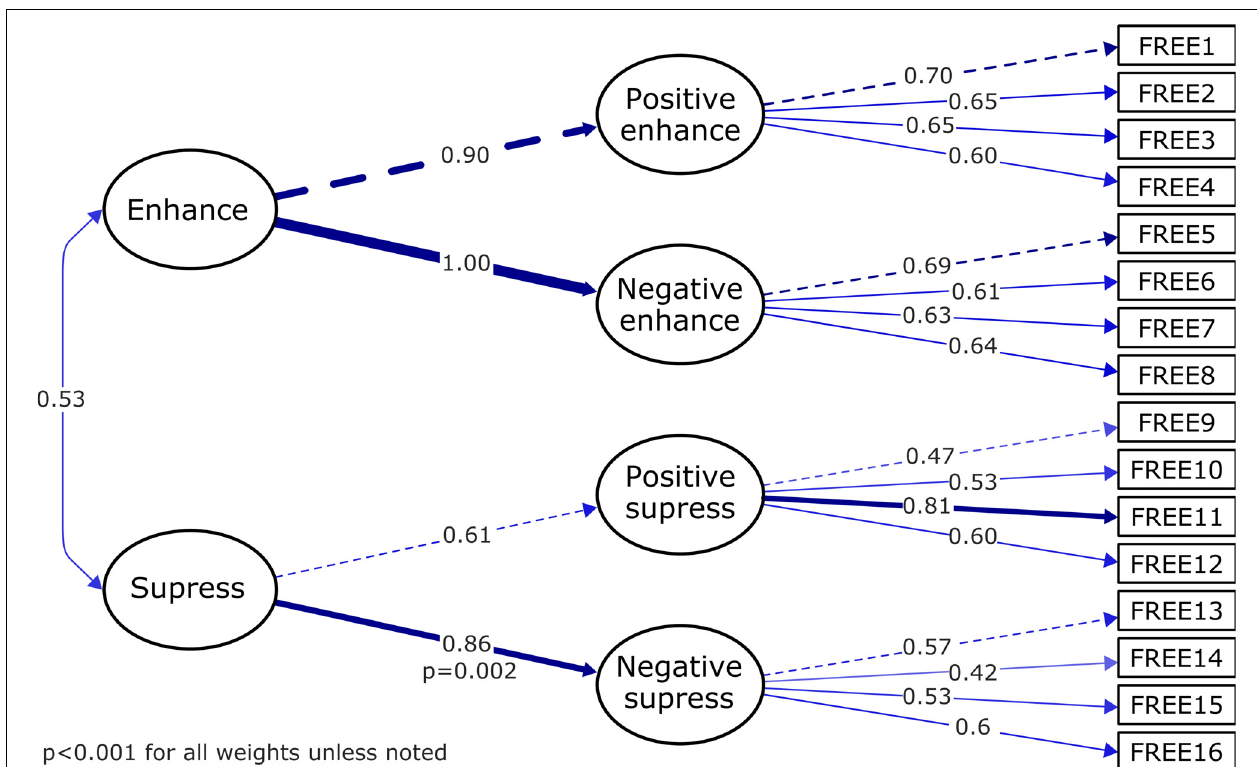
FIGURE 3 | Path diagram of the confirmatory factor analysis (CFA) “hierarchical factor” model. The rectangles indicate the 16 items of the scale, the four directly connected ellipses represent the latent variables, and the two further ellipses are the second-order factors that load into the overall expressive flexibility ability. The lines represent the causal effects of second-order factor to the first-order factors and from those to the individual items, color by the corresponding standardized factor loading also written as a number. The line thickness/continuity indicates the magnitude of the loading